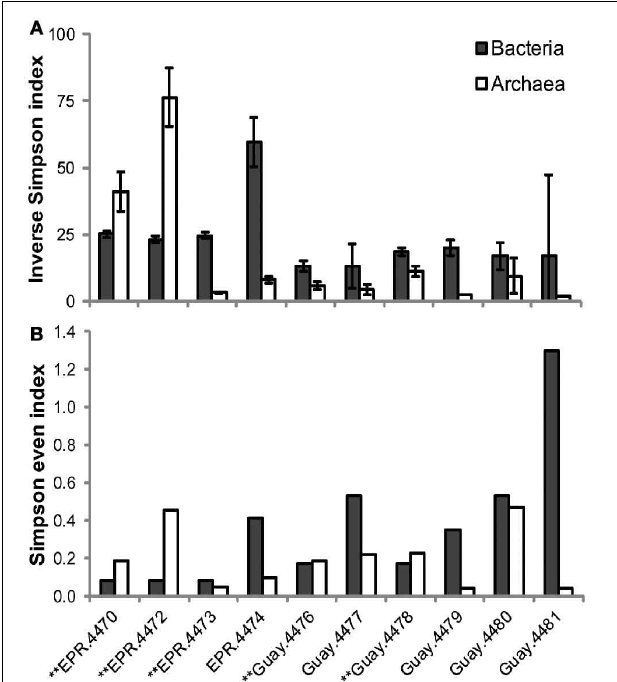
FIGURE 2 | Differential estimation of archaeal and bacterial diversity (A) and evenness (B) in vent-specific 16S rDNA amplicon sequences from diffuse flow samples collected at 9 ◦ N East Pacific Rise (EPR) and Guaymas Basin (Guay) hydrothermal vent sites. ∗∗ Indicates macrofauna-associated diffuse flow site.